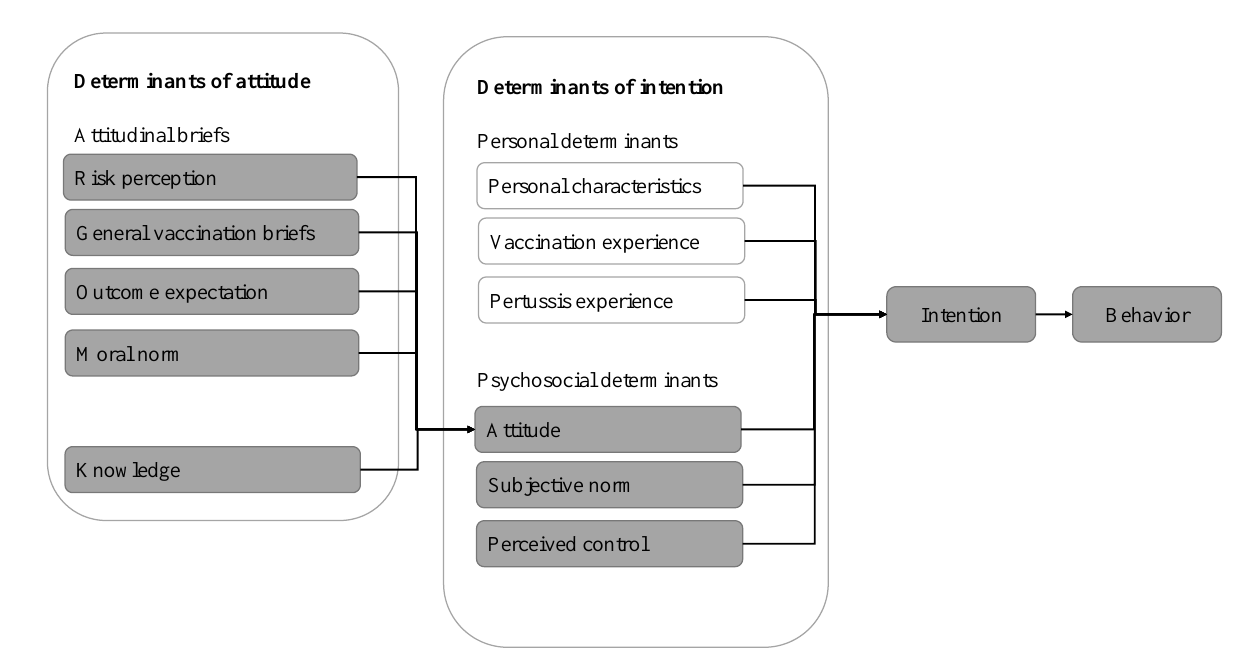
Figure 1. A theoretical framework for accepting a pertussis cocooning vaccination originated from a literature review and the Reasoned Action Approach.